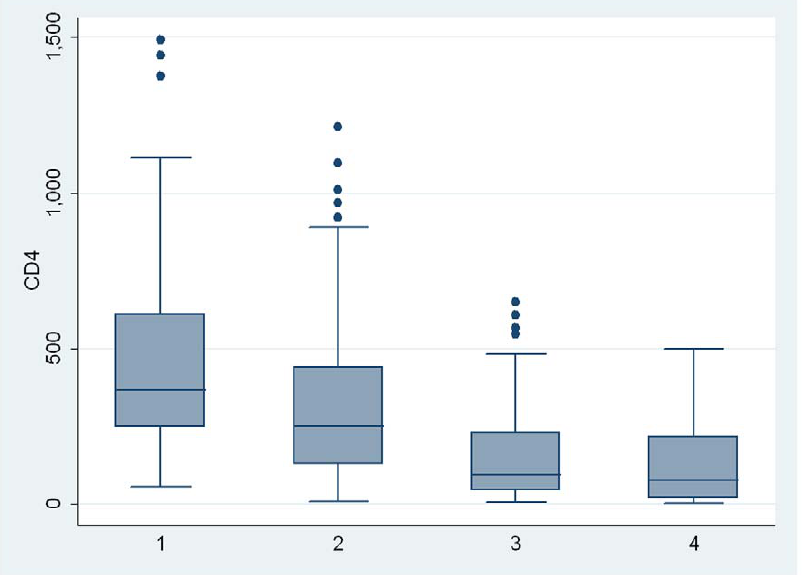
Figure 1. The Box plots showing the median and Inter quartile ranges CD4 cell counts of 395 participants by the WHO HIV/AIDS clinical stages I–IV.